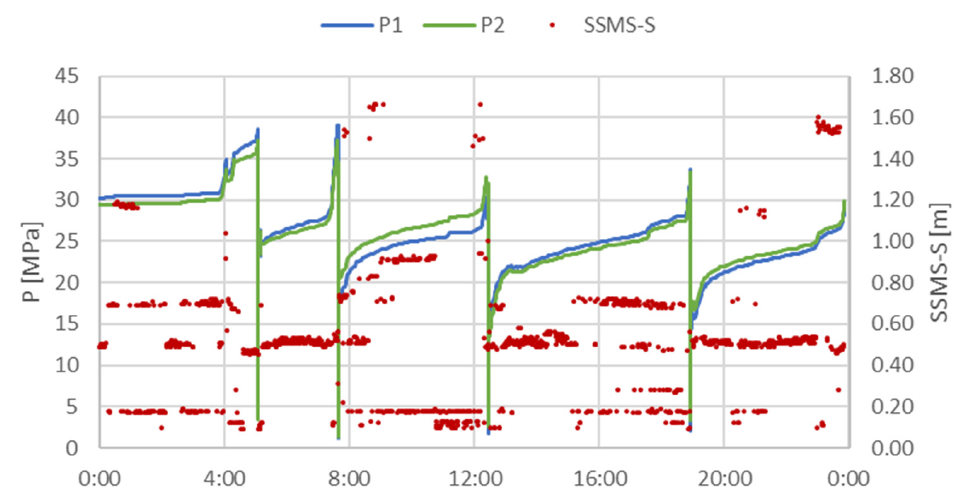
Figure 10. Roof support No. 59 pressure and tip-to face distance (12 February 2021).